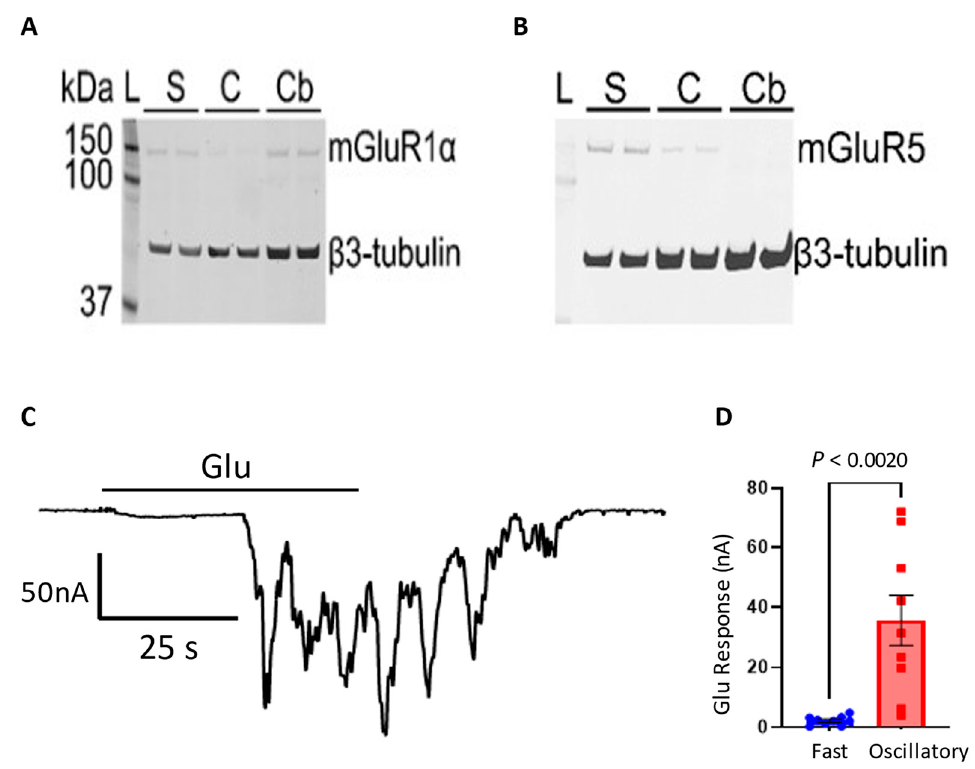
Figure 6. Enrichment of mGluR5 in cortical synaptosomes. Representative immunoblots for mGluR1 α ( A ) and mGluR5 ( B ) of lysates from rat cortex synaptosomes (“S”), cortex (“C”) and cerebellum (“Cb”) probed with anti-mouse mGluR1 α and anti-rabbit mGluR5 antibodies. Bands for mGluR1 α and mGluR5 ran at ∼ 150 kDa. β 3-tubulin ( ∼ 50 kDa) was used as loading control. L , molecular mass marker. Electrophysiological recordings were made ( C ) 24–28 h after injection using synaptic membranes isolated from rat cerebellum with amplitudes ( D ) of oscillatory Glu responses in microtransplanted oocytes showing responses (35.74 ± 8.38 nA; n = 9 oocytes from 1 frog; Mean + SEM). Paired t test.